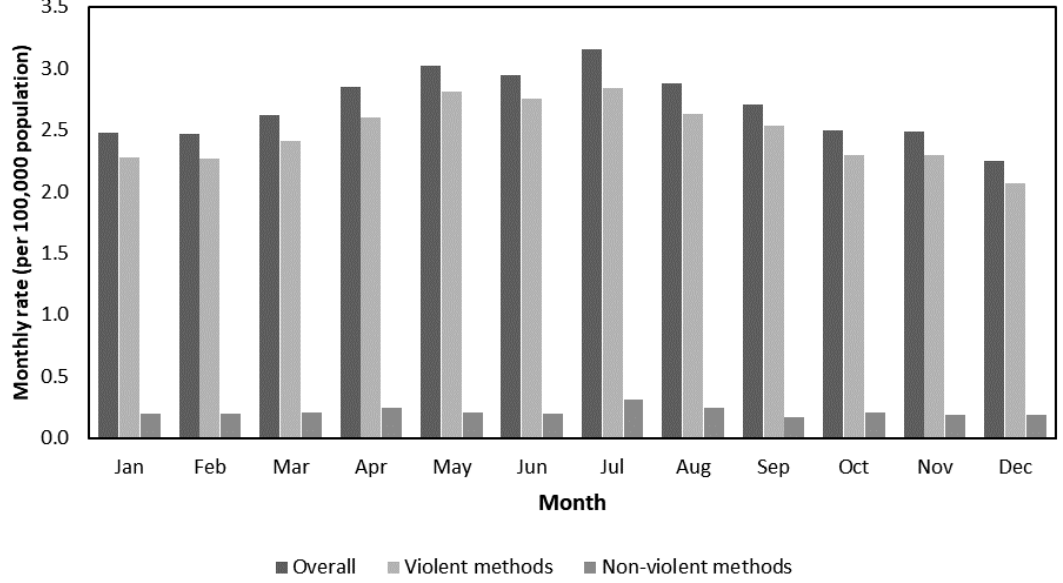
Figure 1. Average monthly rates # of older-adult suicide deaths in Hong Kong, 1976–2014. # Adjusted to 30 days in a month.